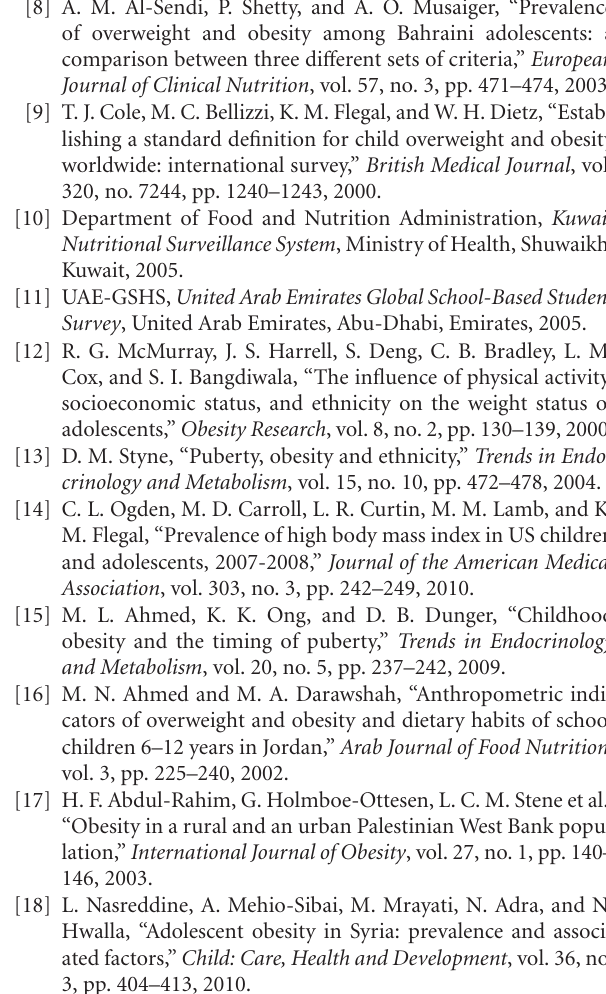
Overweight IOTF CDC IOTF CDC M 9.3 F M M F M F M M